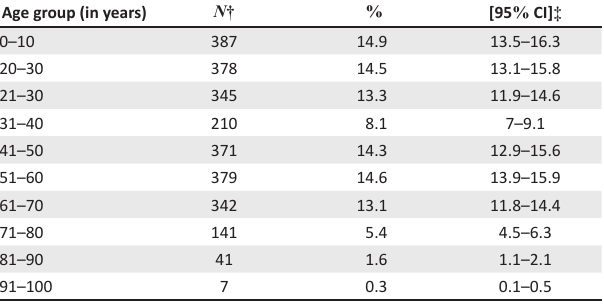
TABLE 2: Distribution of age for patients who visited the Saudi Arabian public eye care clinics over the 6 month period of the study. Age group (in